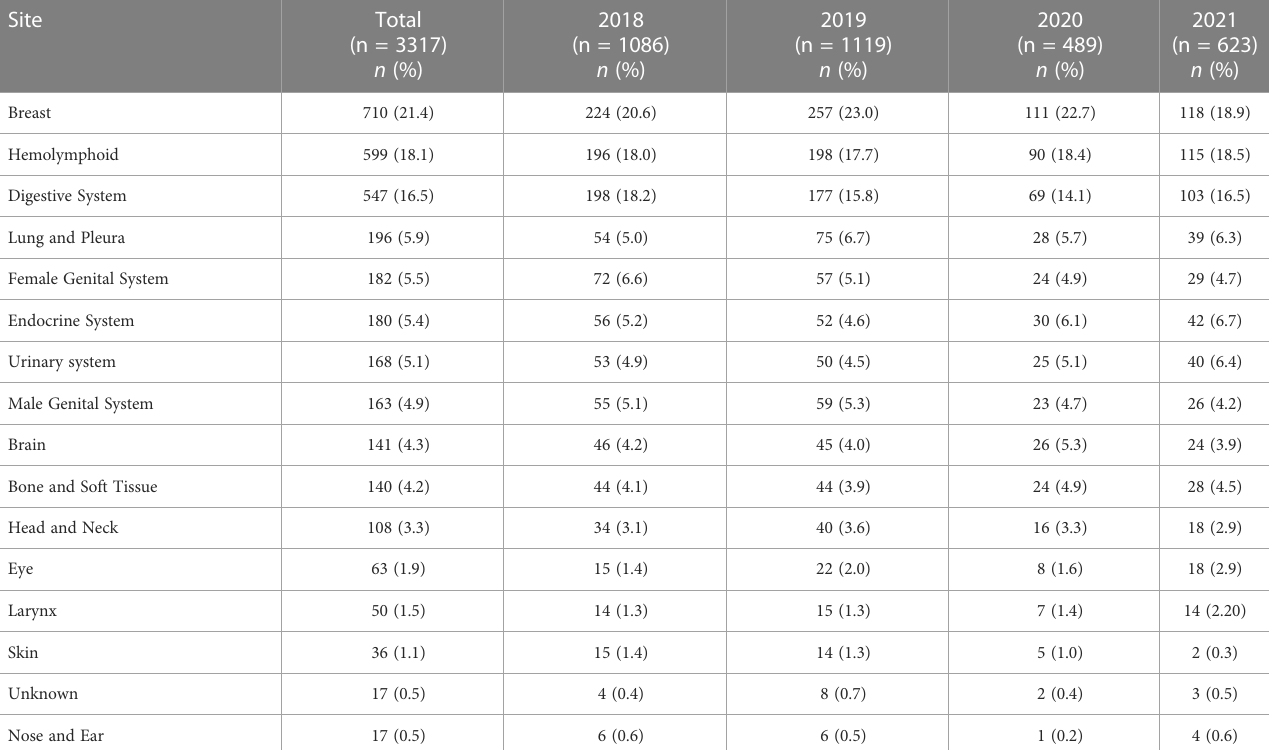
TABLE 2 Site-speci fi c frequencies of cancers in patients from areas of con fl ict who presented to the King Hussein Cancer Center between 2018 and 2021 strati fi ed by year of fi rst contact.